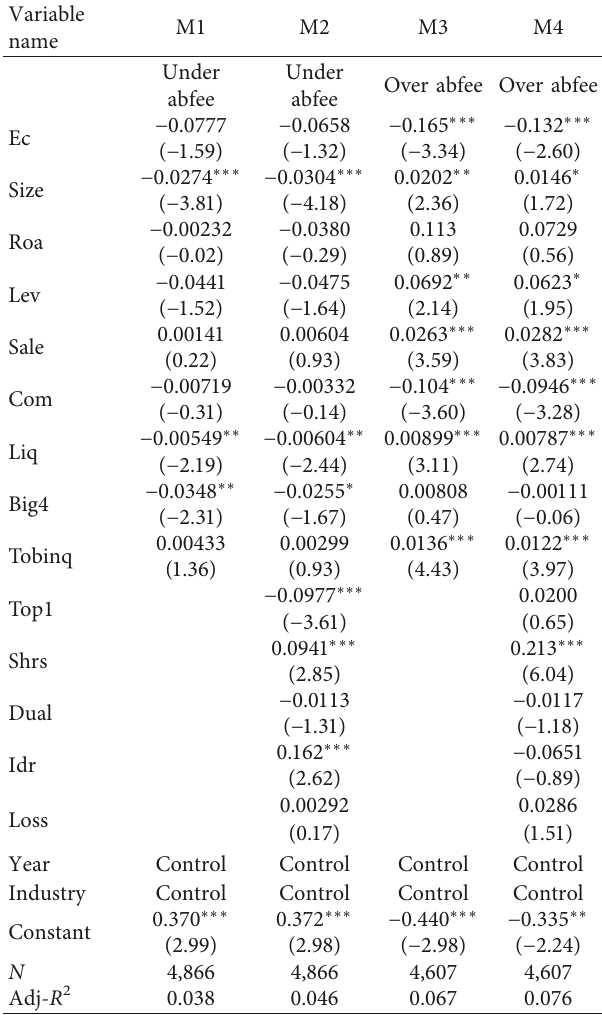
Table 4: OLS regression results of positive and negative abnormal audit